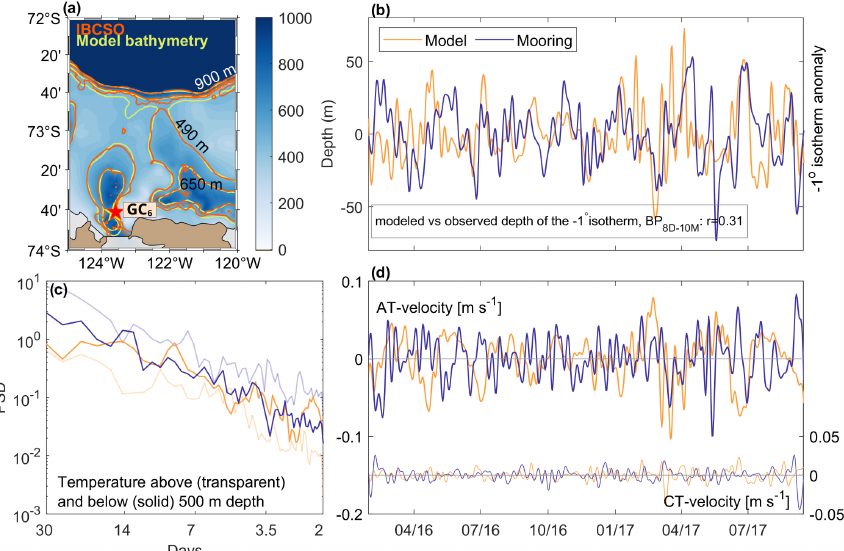
Figure A1. Comparison between (a) selected isobaths from the IBCSO (orange) and the model’s bathymetry (yellow) (GC 6 ’s location: red star). 650m is the mooring depth and at 490m the model bathymetry indicates that the trough northeast of GC 6 is open, whereas it is closed in the IBCSO data. (b) The anomaly of the − 1 ◦ C isotherm depth, (c) the Fourier spectra of mean temperature above (transparent) and below (solid) a depth of 500m, and the (d) rotated along-trough current (AT velocity, left axis) and cross-trough current (CT velocity, right axis) at the mooring of GC 6 (blue) and at the mooring location in the model (orange). Isotherm depth anomalies and rotated velocities are filtered with BP 8D–10M